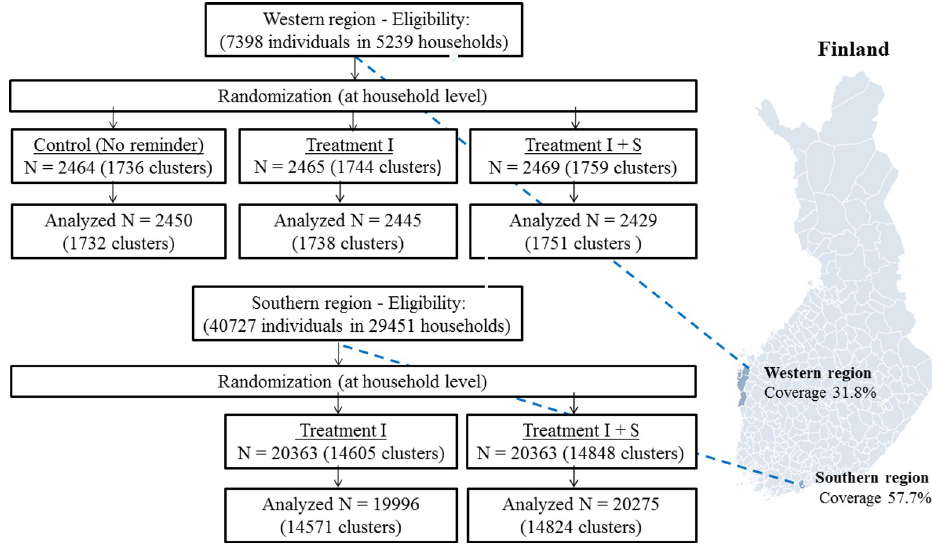
Fig 1. Study regions and randomization scheme. The map in Fig 1 was created for this article in R software using open source data (CC BY 4.0) from Statistics Finland. The base layer of the map used in Fig 1 is available at Statistics Finland’s map service (https://tilastokeskus-kartta.swgis.fi/?lang=en). The R code and shapefiles to reproduce the map in Fig 1 are available at https://osf.io/v453z/. Control = no reminder, Treatment I = individual-benefit reminder, Treatment I + S = individual- and social-benefit